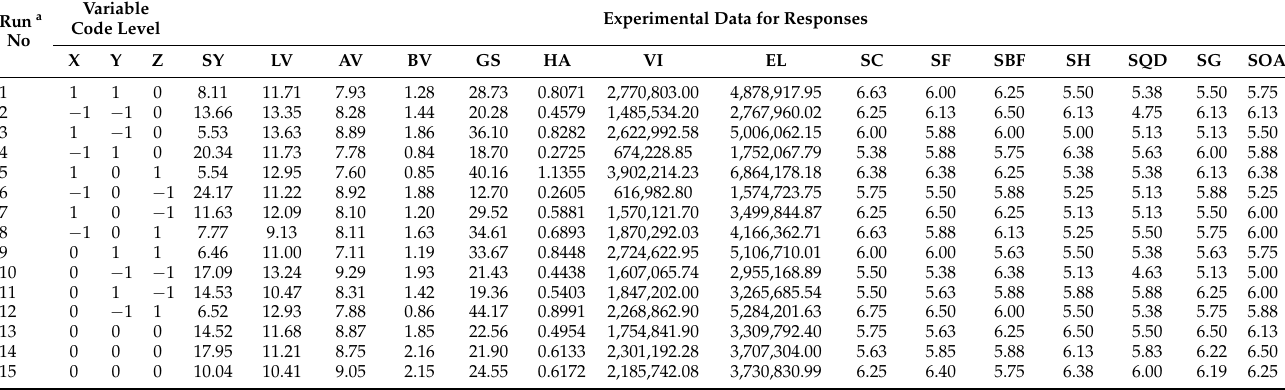
Table 3. Experimental data for various responses of sweet adzuki-bean jelly cake with different combinations of agar concentration (X), sugar content (Y), and concentration time (Z) used in the design for response surface